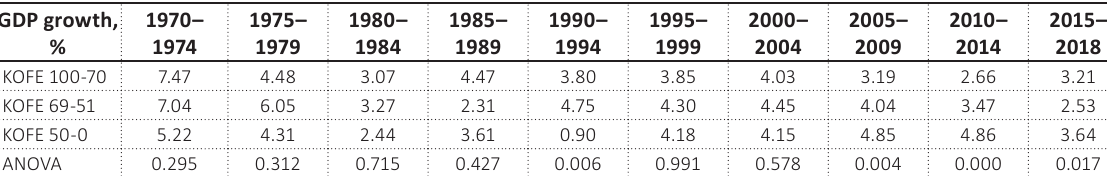
Table 3. Mean values of GDP growth with respect to economic globalization GDP growth,